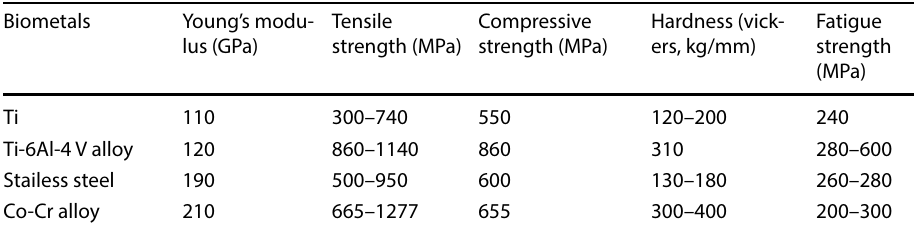
Table 3 Metals mechanical properties [134]